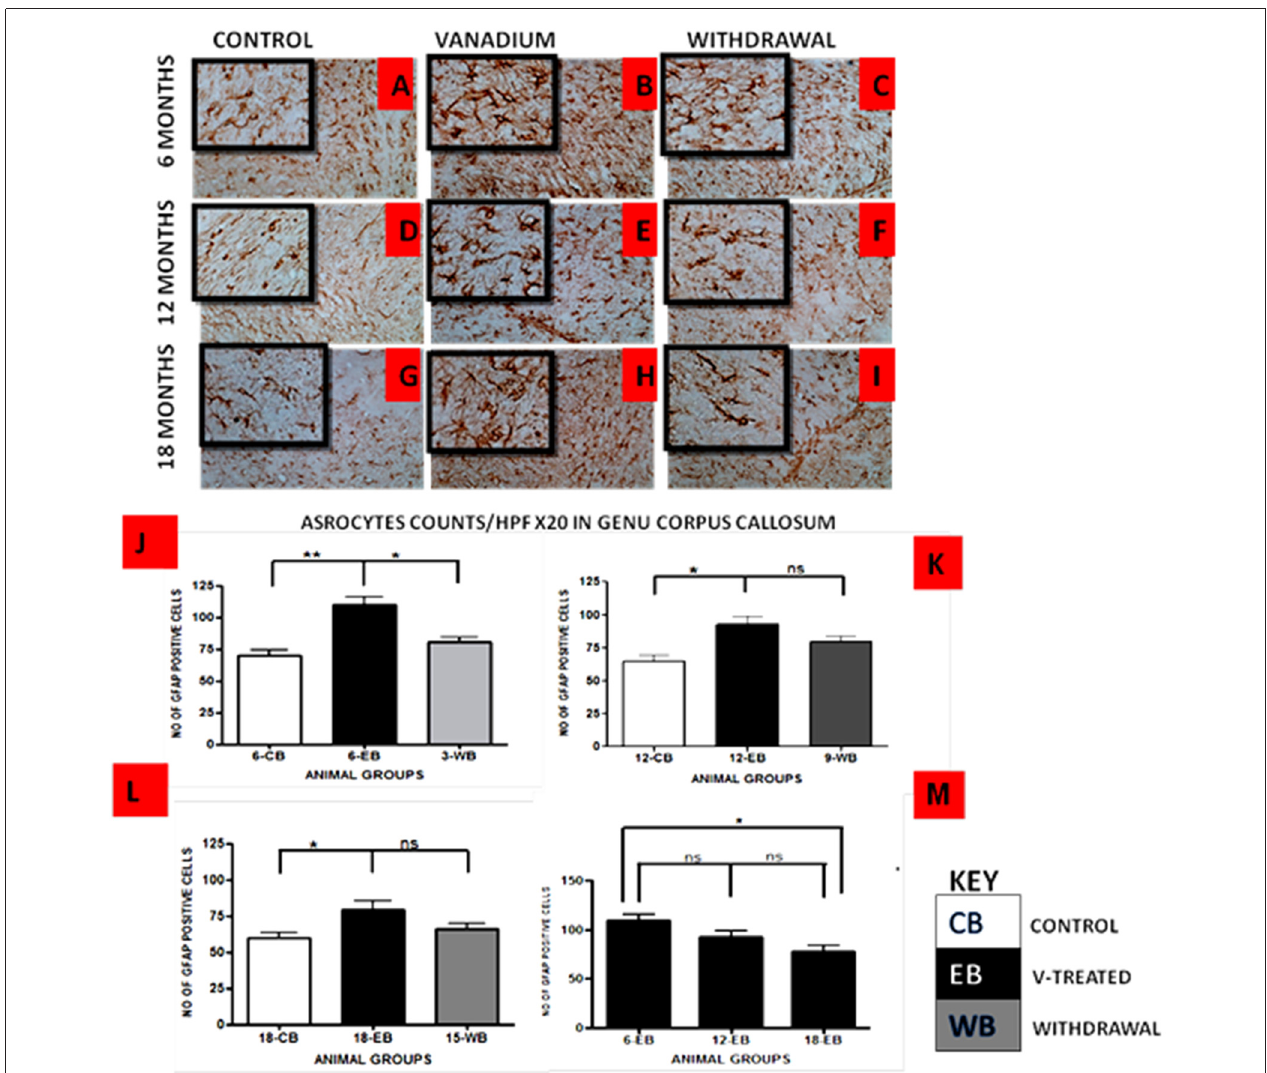
FIGURE 3 | GFAP-immunostained Genus corpus callosum of vanadium exposed (B,E,H) , age matched control (A,D,G) and withdrawal group (C,F,I) mice. Vanadium treatments for 6, 12 and 18 months revealed astrocytic activation identified by thickened cell body with more tortuous cytoplasmic processes relative to the matched controls while the withdrawal groups showed reversal effect relative to vanadium exposed groups. The number of GFAP positive cells were counted by two blinded investigators and average of N = 5 per group counts are shown per HPF (20 × ) in (D–F) respectively. The differences between groups (J–L) were evaluated for significance using ANOVA ( ∗ p < 0.05; ∗∗ p < 0.01). Astrocytic response decreases into old age with increasing vanadium exposure ( M ; 6EB vs. 18EB = ∗ p < 0.05). Magnification: × 200, inset: ×